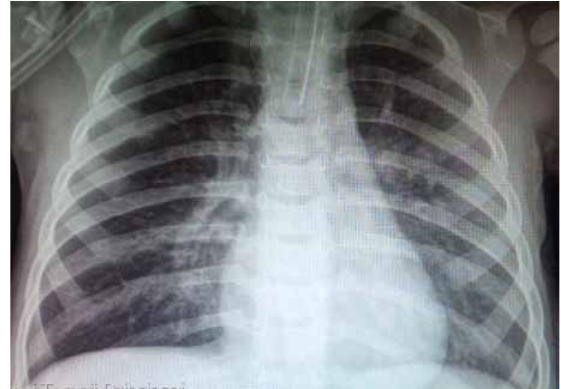
Figure 2. Recurrent bronchopneumonia in a 10-month-old intubated patient (an orange petiole was removed during bronchoscopy).